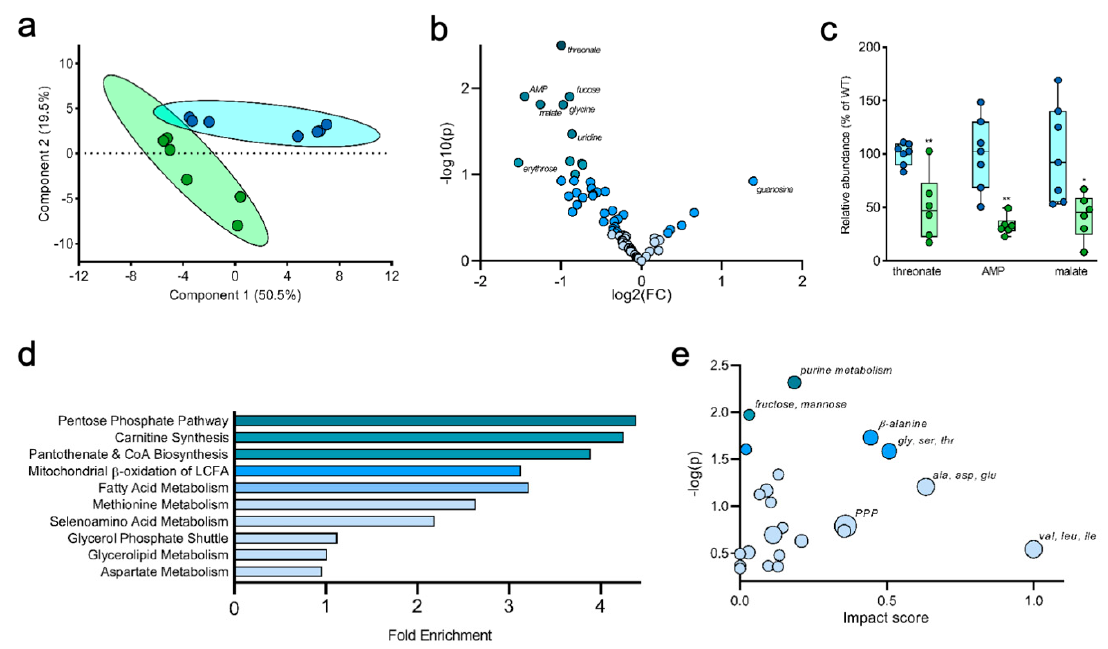
Figure 4. Non-tracer metabolomics analysis . ( a ) Principle component analysis distinguishes between the metabolic profile of 5XFAD brain from WT based on 80 metabolites identified by GCMS analysis. ( b , c ) A change volcano plot separates metabolites based on degree of change versus statistical significance among 5XFAD and WT ( b ), and select metabolites identified in Figure 4b are further highlighted in Figure 4c by direct comparison of their relative abundance. ( d ) Fold-enrichment analysis compares the major metabolic pathway differing between 5XFAD and WT. ( e ) Pathway impact analysis provides a multi-dimensional illustration of metabolic pathways based on pathway enrichment analysis, pathway topology analysis, and statistical significance. Values shown are mean ± SEM ( n = 6–7) ( c ). Data analyzed by unpaired t -test ( c ). * p < 0.05; ** p < 0.01.